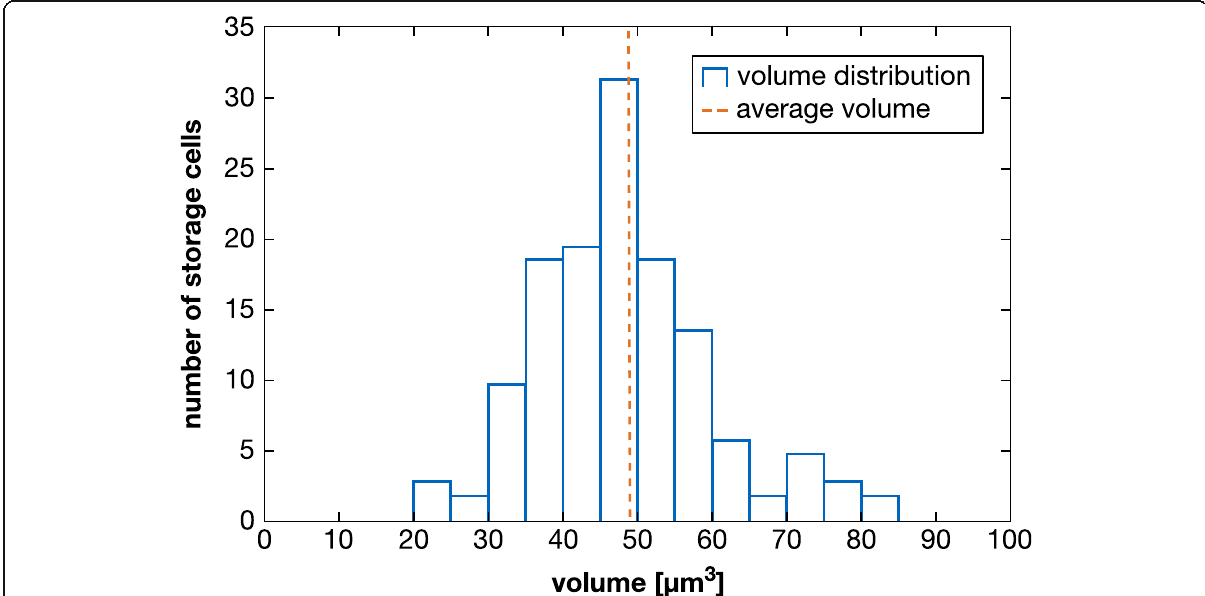
Fig. 4 Distribution of storage cell volumes. The blue bars depict the volume distribution of the 137 storage cells in the investigated specimen for a bin size of 5 μ m. The dashed orange line indicates the average volume of 48.2 μ m